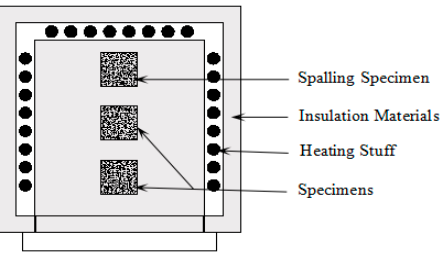
Figure 5. Section drawing of the furnace.